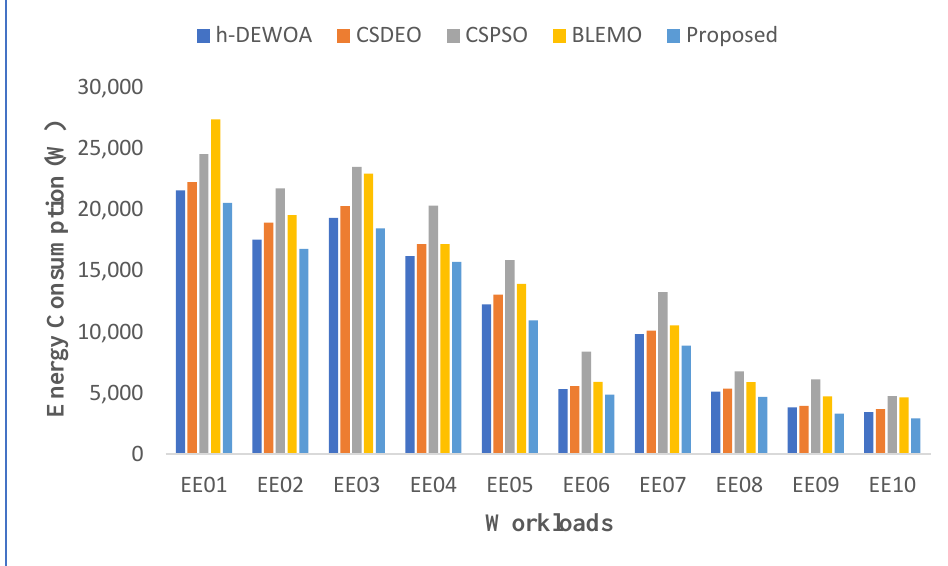
Figure 7. Comparison of energy consumption for HPC2N workload.